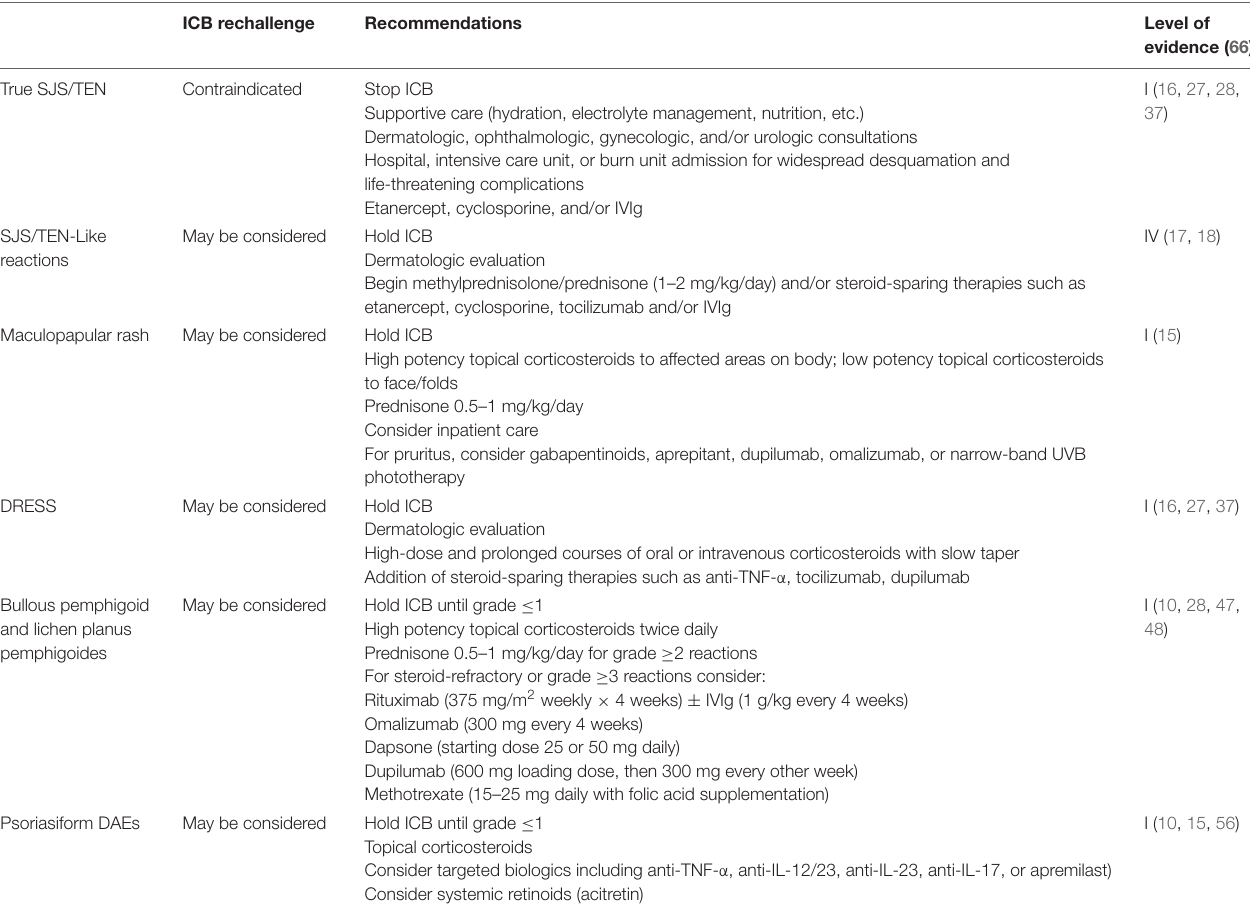
TABLE 2 | Management of high grade